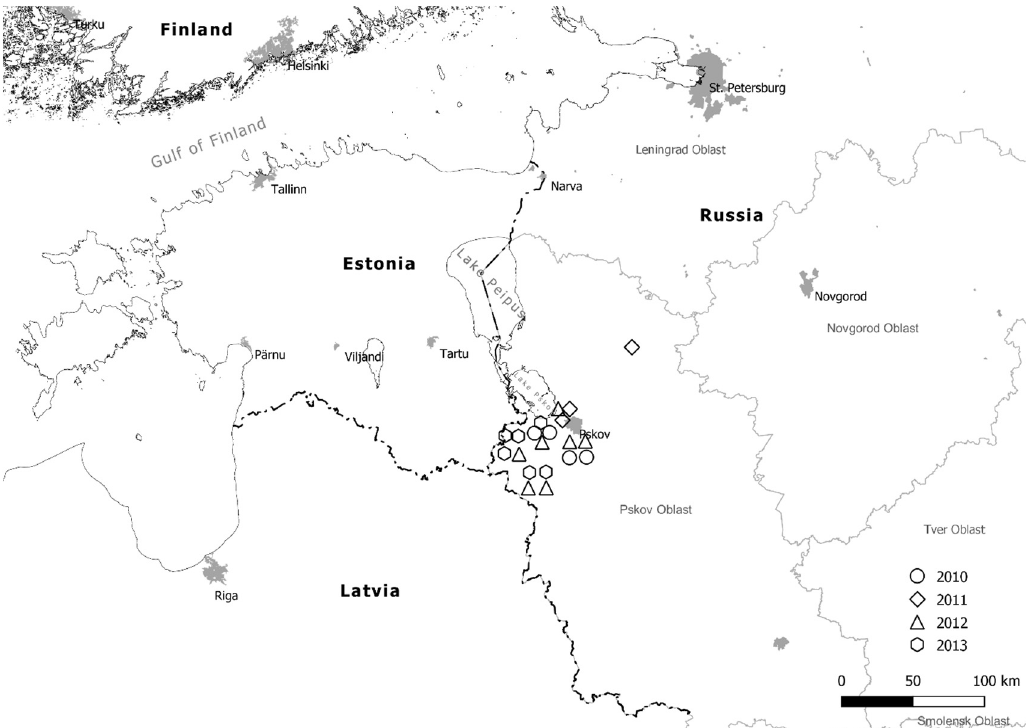
Figure 1. Map of Pskov region potato fields in north-west Russia where the isolates of Phytophthora infestans were collected during